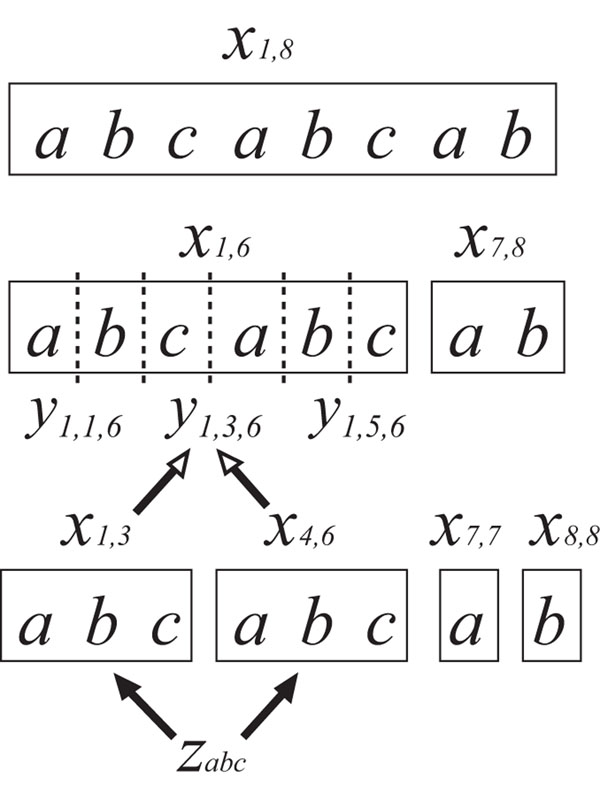
Illustration of the minimum CFG for a string “abcabcab” In the minimum CFG, the substring “abc” is generated from a nonterminal symbol Aabc. Then, zabc = 1, x1,3 = 1, and x4,6 = 1. To generate “abcabc”, that is, x1,6 = 1, at least one variable of y1,k,6 (k = 1,⋯,5) must be 1, that is, the substring s1,6 must be divided into s1,k and sk+1,6. Here, y1,3,6 = 1 because x1,3 = x4,6 = 1. Then, the production rule Aabcabc → AabcAabc appears.